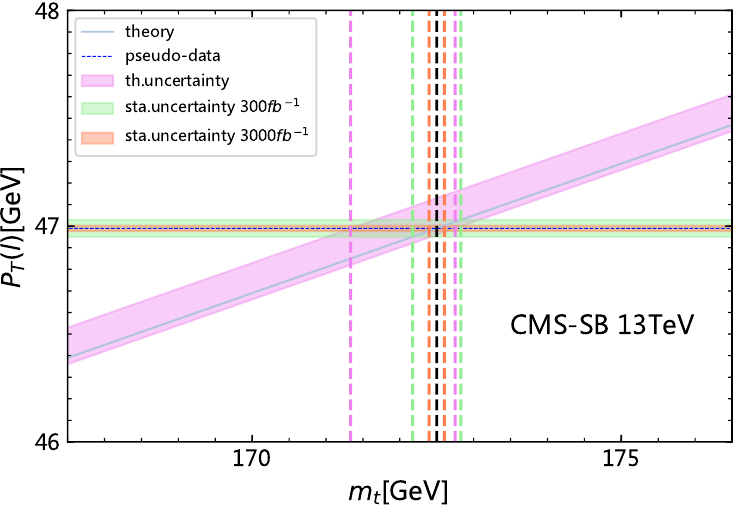
Figure 7 . Predictions on the average transverse momentum of the charged lepton in the signal process as a function of the top-quark mass (band along diagonal direction) and the projected measurement on the same quantity with only statistical errors (horizontal bands). Extracted top- quark mass with various uncertainties are indicated by vertical lines.